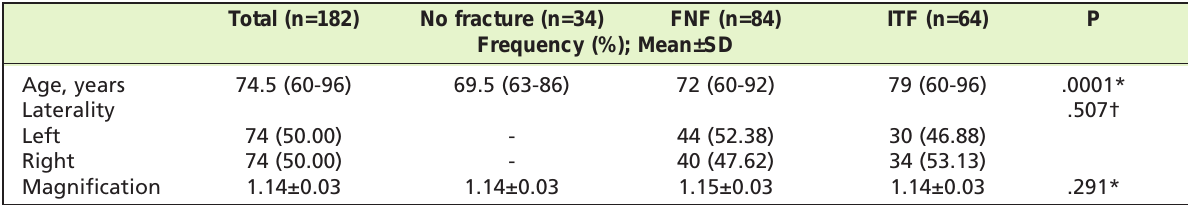
Demographic profile of patients (n=182) Table I: